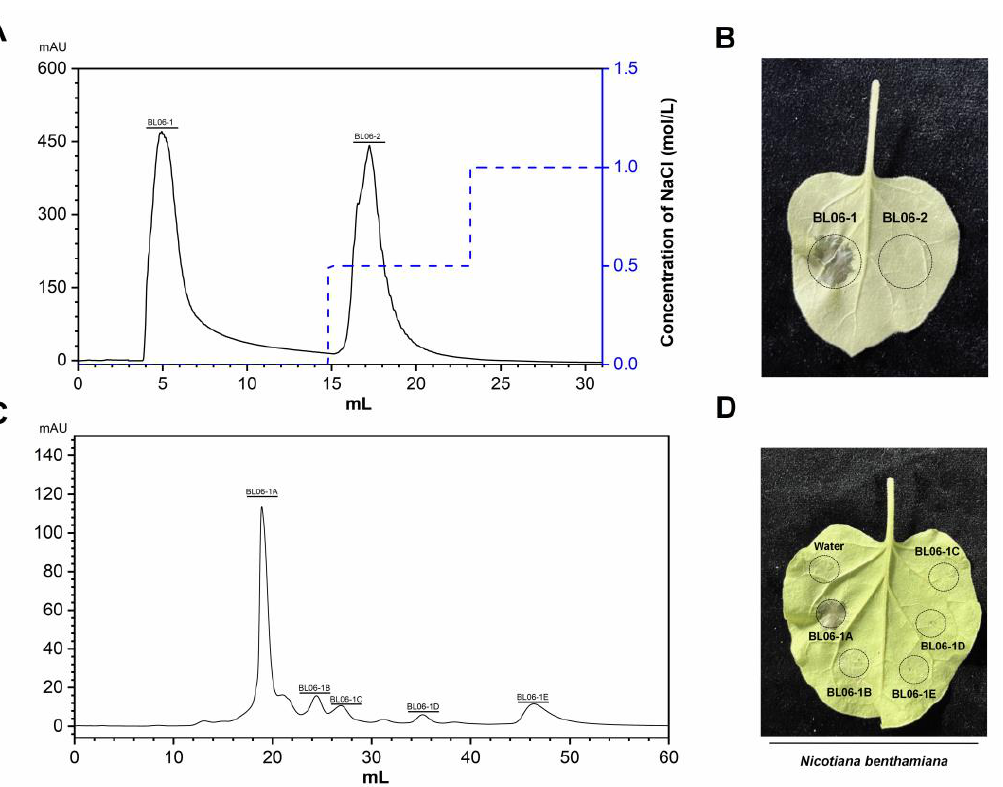
Figure 1. Isolation, purification, and activity verification of the Bacillus licheniformis (BL06) exoprotein. ( A ) Elution curve of the BL06 exoprotein by HiTrap Capto Q chromatography; ( B ) Induction of cell death in Nicotiana benthamiana leaves by BL06-1 and BL06-2; ( C ) The elution curve of BL06-1 by Superdex75 chromatogram; ( D ) Induction of cell death in N. benthamiana leaves by BL06-1A-1E.